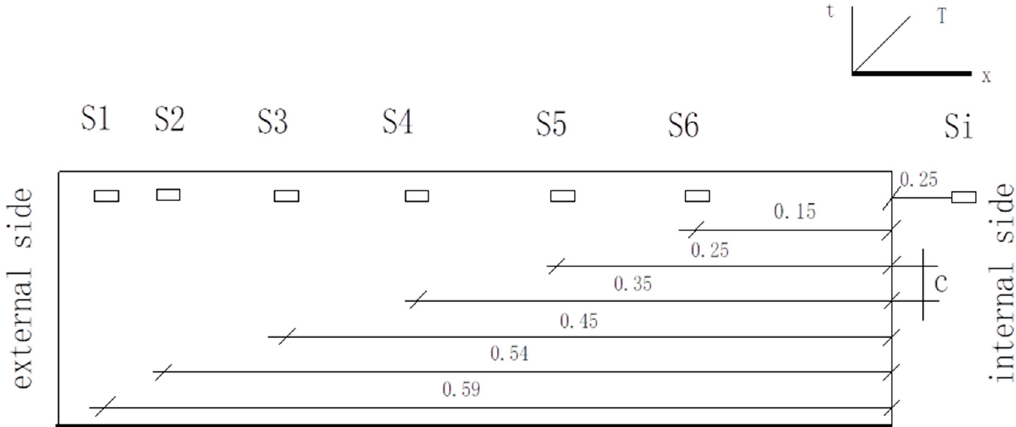
Figure 1. Arrangement of temperature sensors in the wall.